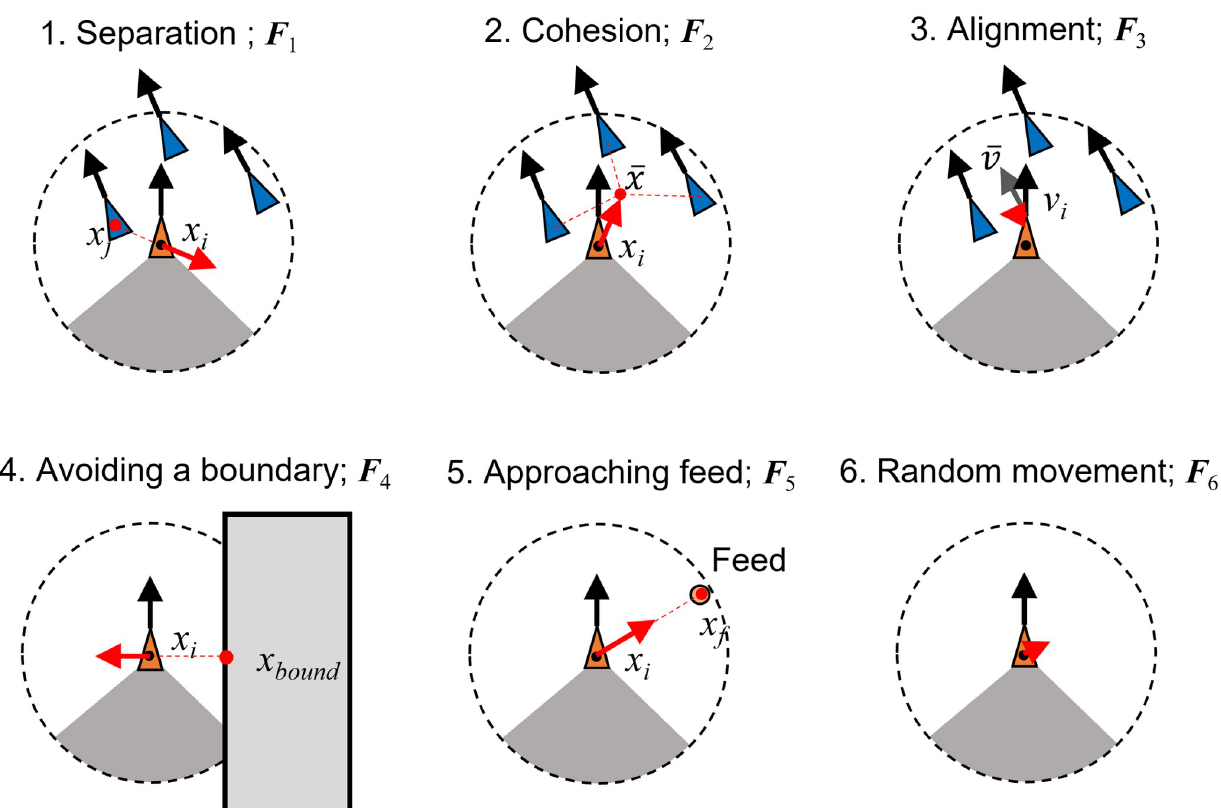
Fig 4. Overview of each force vector. Here, the behavioral model was based on the boid model [13]: 1. Separation, 2. Cohesion and 3. Alignment. Three additional rules were considered, 4. Avoiding a boundary, 5. Approaching feed, and 6. Random movement. Swimming force was expressed as the sum of the forces